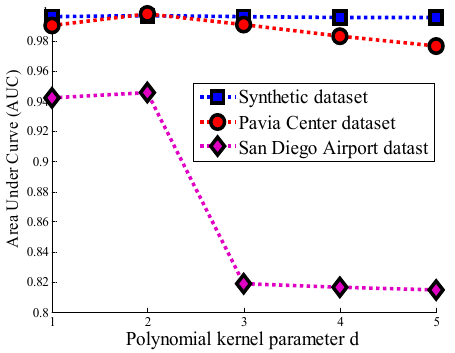
Figure 10. Area under the curve (AUC) of the progressive line processing Kernel-RX detector (PLP-KRXD) with a different polynomial kernel parameter d on three datasets: Synthetic dataset, Pavia Center dataset, and San Diego Airport dataset.